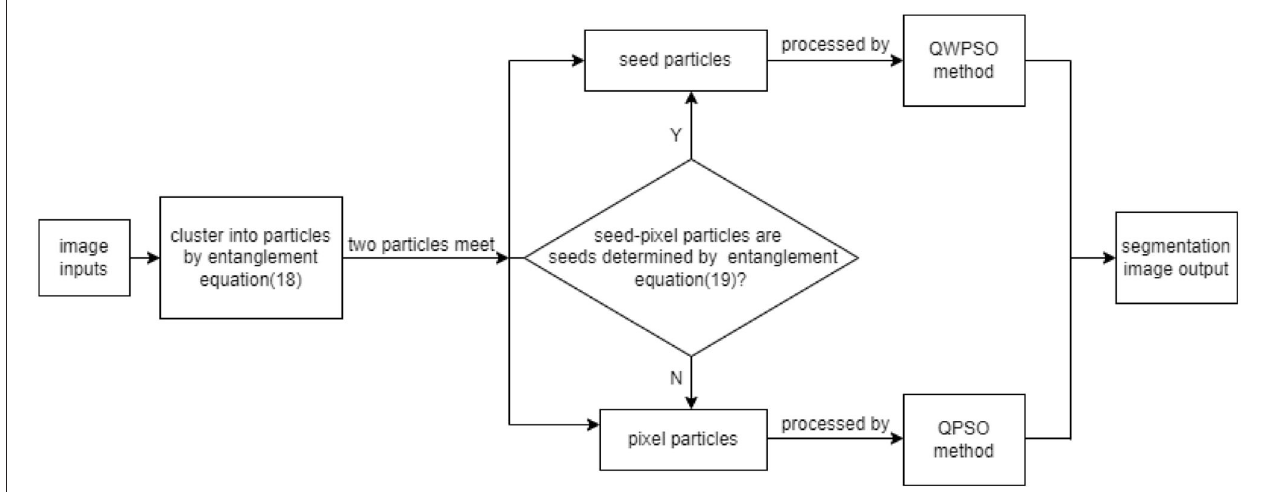
FIGURE 3 | The framework of quantum and wormhole-behaved particle swarm optimization (QWPSO)